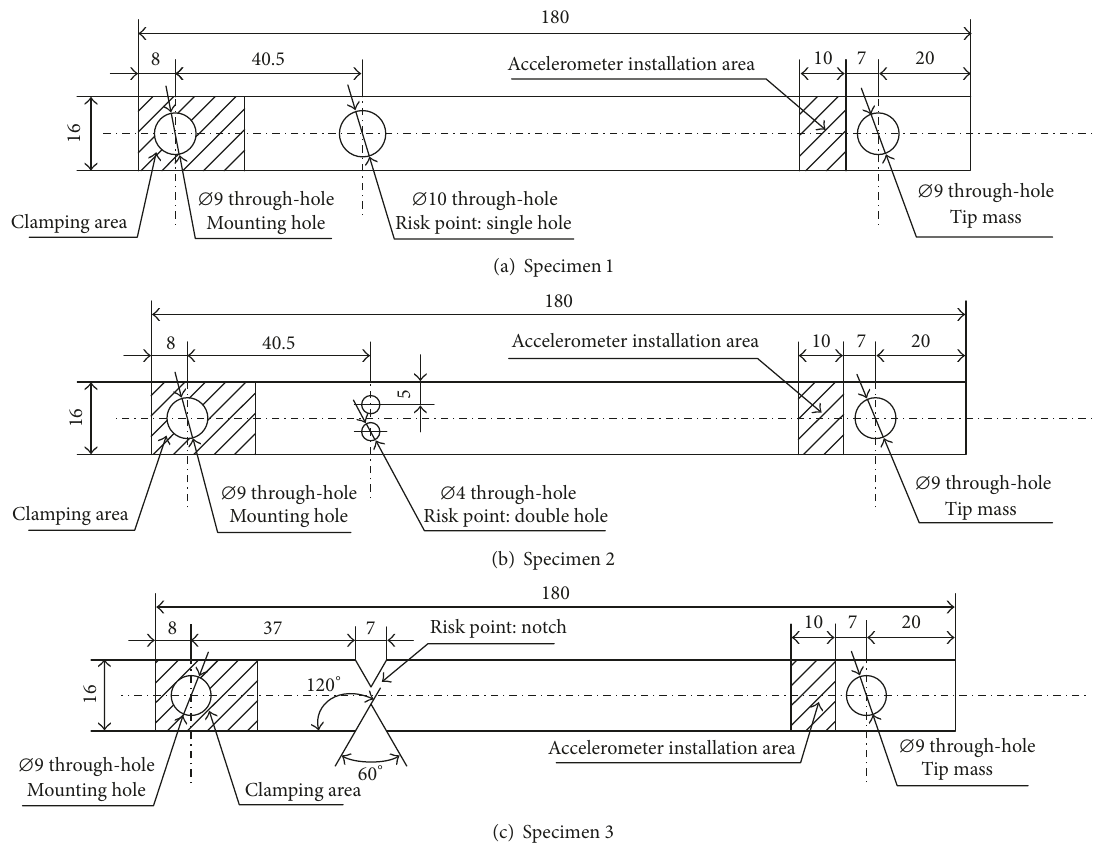
Figure 8: The specimen of vibration